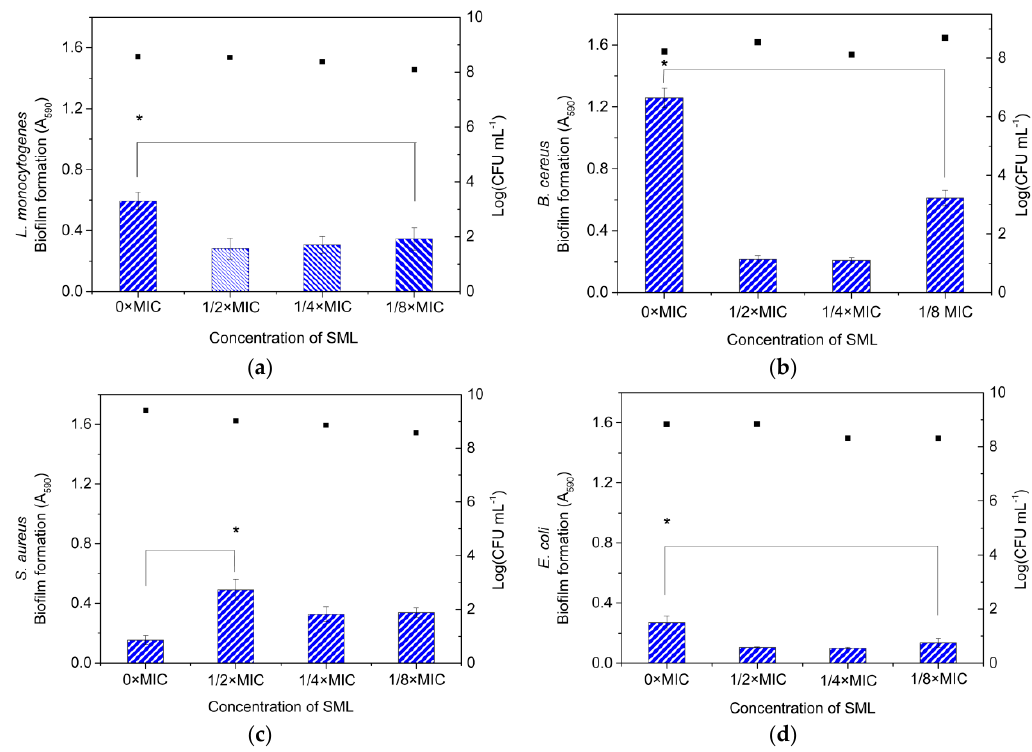
Figure 5. Effect of different concentrations of SML on the biofilm formation of ( a ) L. monocytogenes ; ( b ) B. subtilis ; ( c ) S. aureus ; ( d ) E. coli . The error bars represent the standard deviations, and the asterisks indicate significant difference between each other.